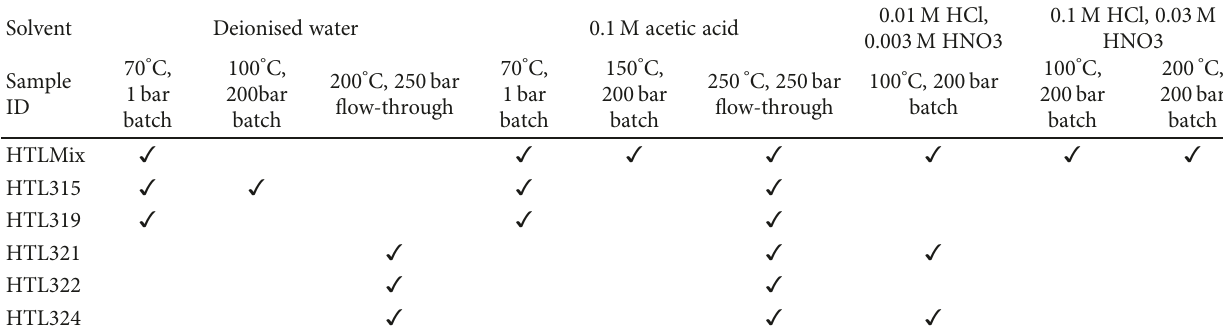
Table 2: Summary of experimental materials and conditions